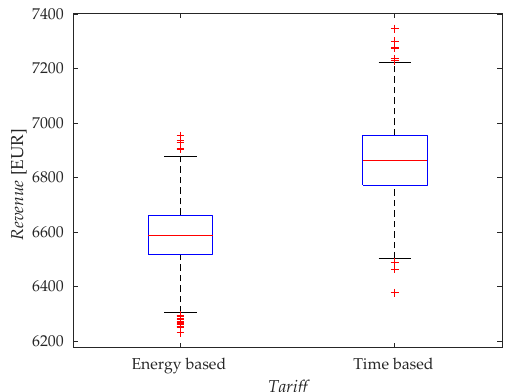
Figure 10. Annual revenues of the CSO for the two types of